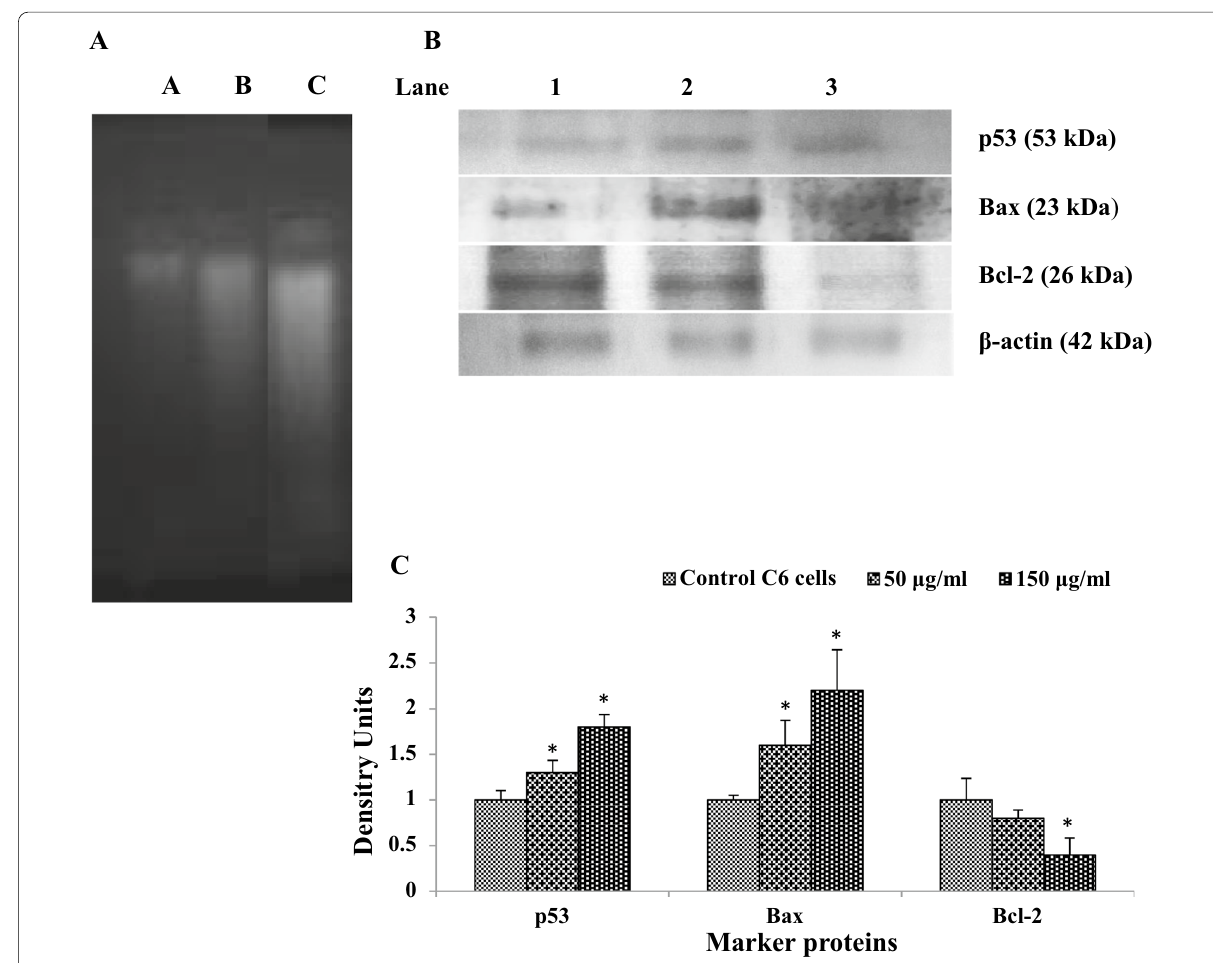
Fig. 5 Fraction 1-induced apoptosis on C6 cells for 24 h incubation. A DNA fragmentation, Lane A—Control C6 cells, Lane B—50 μg/ml concentration, Lane C—150 μg/ml concentration. B Western blot analysis, Lane 1: control, Lane 2: 50 μg/ml, Lane 3: 150 μg/ml. C Densitometric analysis. The densitometric analysis was performed using ImageJ software and expressed as relative intensity units. Results are given as statistically significant at p ˂ 0.05. *donates between control and cells treated with fraction 1 for 24 h